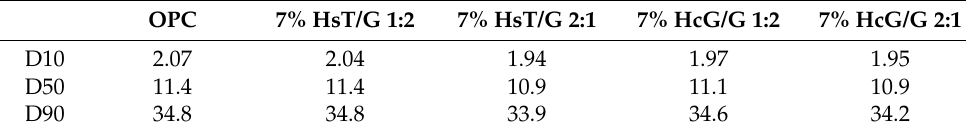
Table 3. D10, D50, and D90 values ( µ m) for the cements